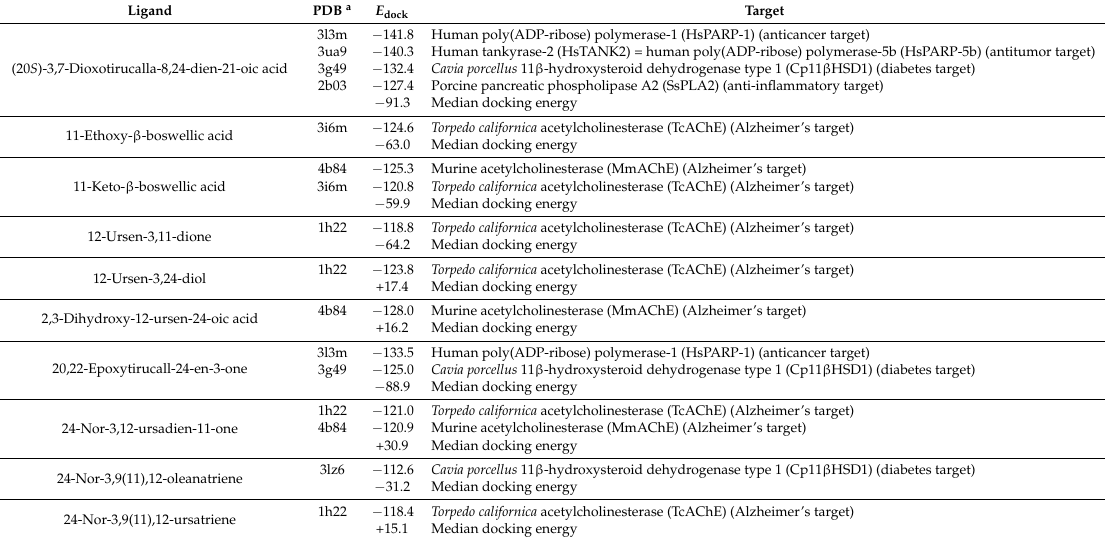
Table 6. Protein targets with the most exothermic docking energies ( E dock , kJ/mol) for Boswellia triterpenoid